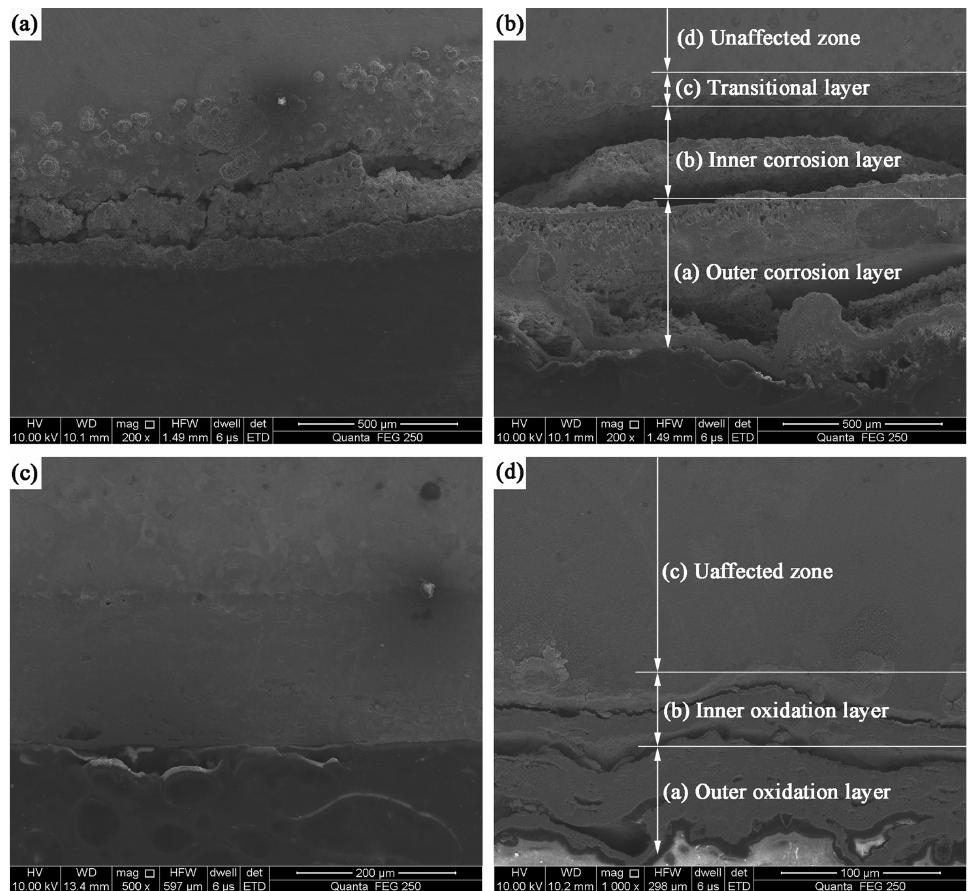
Figure 5: SEM micrograph of the cross sections of corrosive specimens at (a) 973.15K/100MPa, (b) 998.15K/100MPa and bare specimens at (c) 973.15K/100MPa, (d)